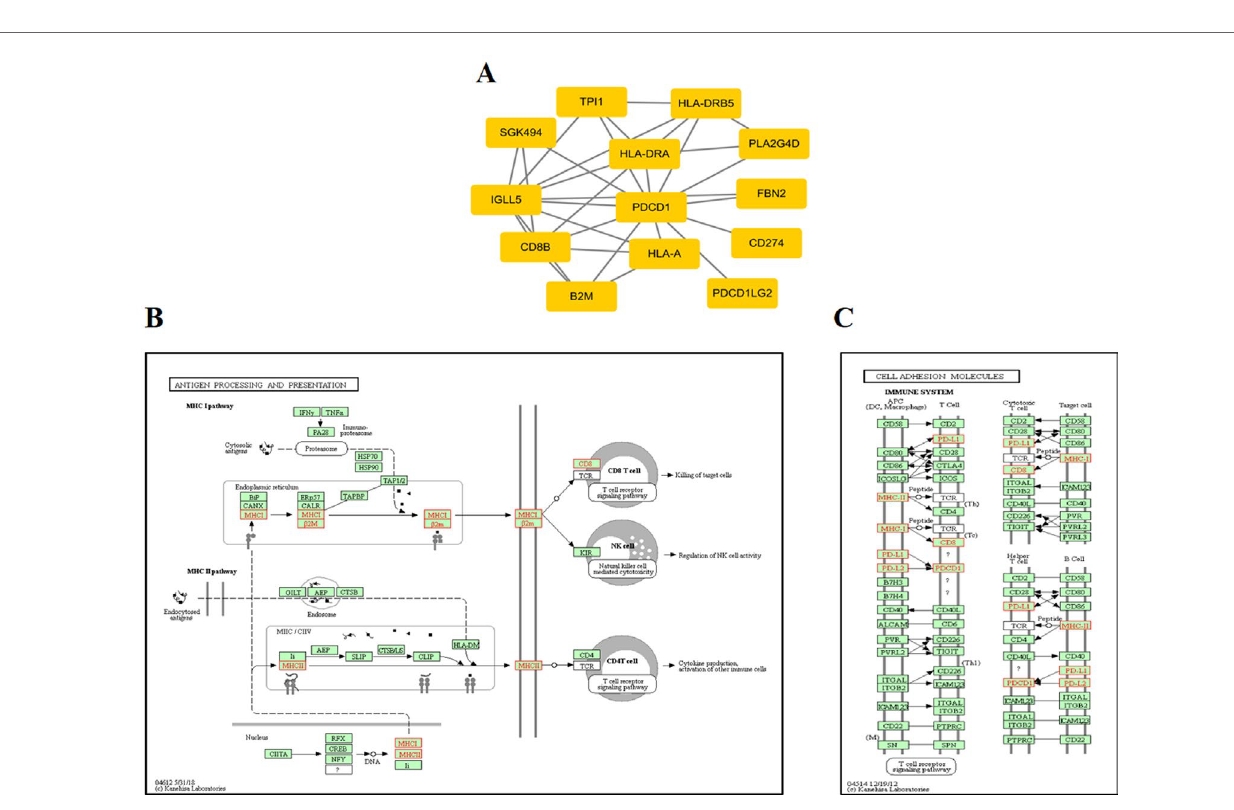
FIGURE 5 | ORR-associated subnetwork map of KEGG pathways. (A) PDCD1 and its interacting genes in protein-protein interaction (PPI). (B) The pathway of antigen processing and presentation. (C) The pathway of cell adhesion molecules (CAMs); the golden yellow color represents the genes in the subnetwork of PDCD1.